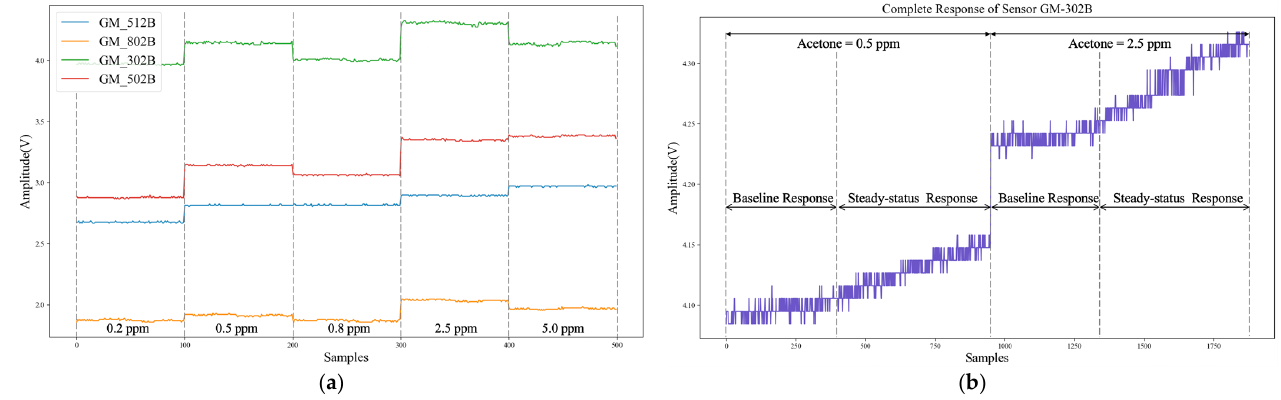
Figure 8. Collected Response Data of MEMS Sensor Array: ( a ) Steady-status sensor response at different acetone concentrations; ( b ) Complete Response of Sensor (GM-302B) under 0.5 ppm and 2.5 ppm.